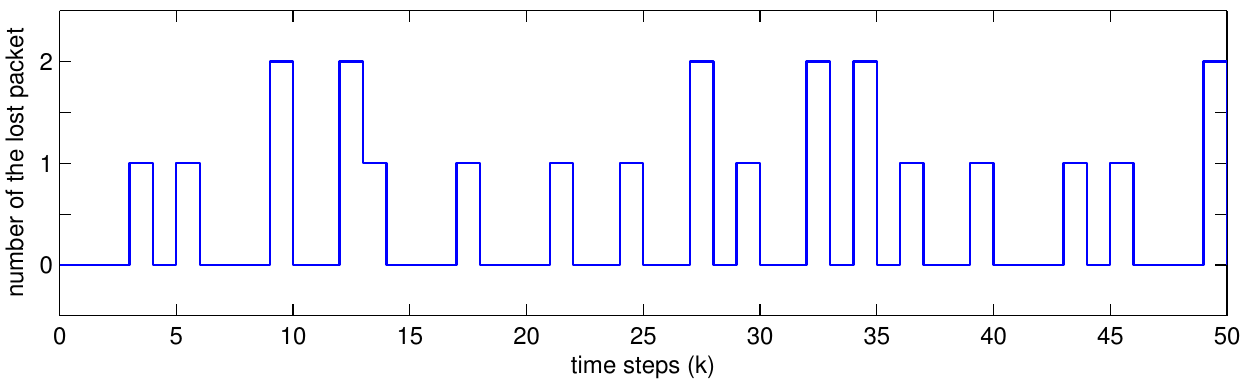
Figure 2. The number of the lost